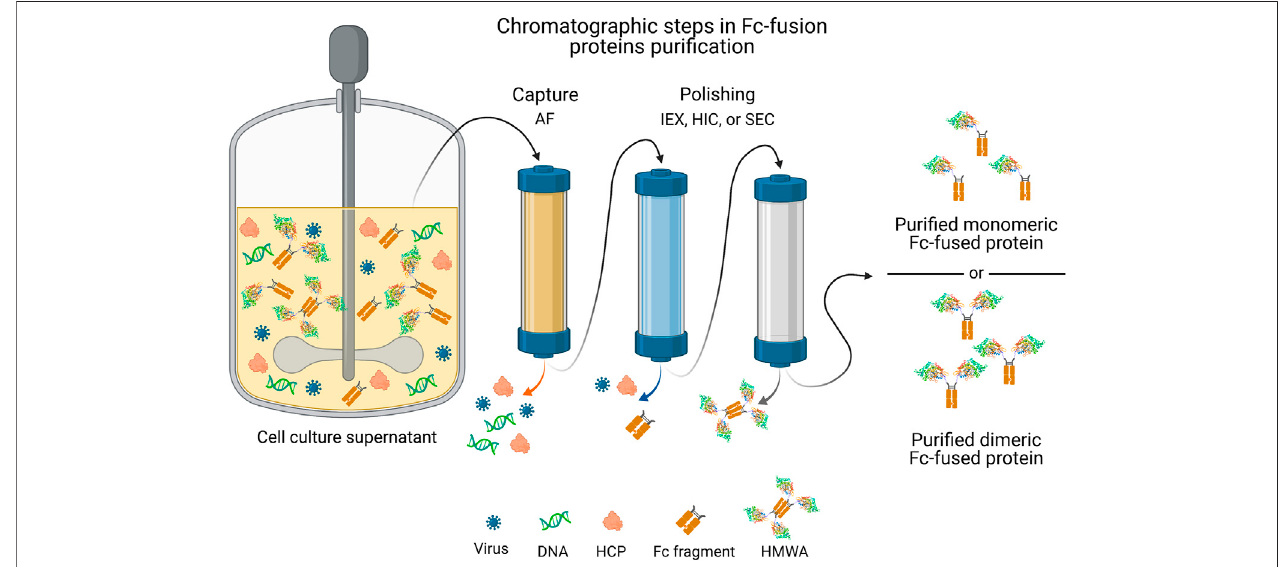
FIGURE 3 | General strategy of chromatographic steps in the puri fi cation process of commercial Fc-fusion proteins produced in mammalian cells culture. A single capture step is followed by two polishing steps that involve a combination of chromatographic operational modes to obtain the puri fi ed monomeric or dimeric Fc-fusion protein. AF, af fi nity chromatography; HCP, host cell proteins; HIC, hydrophobic interaction chromatography; HMWA, high molecular weight aggregates; IEX, ion exchange chromatography; SEC, size exclusion chromatography. Fc-fusion protein structures are merely representative, the current structure for each Fc-fusion protein may